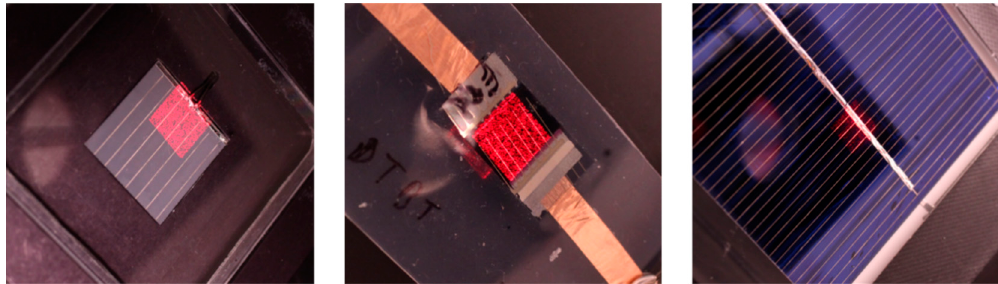
Figure 3. The three samples used in this work, with a random pattern for compressive sampling projected on them. On the left is the c-Si reference cell, in the middle is the organic photovoltaic (OPV) device, and on the right is the large mc-Si cell.